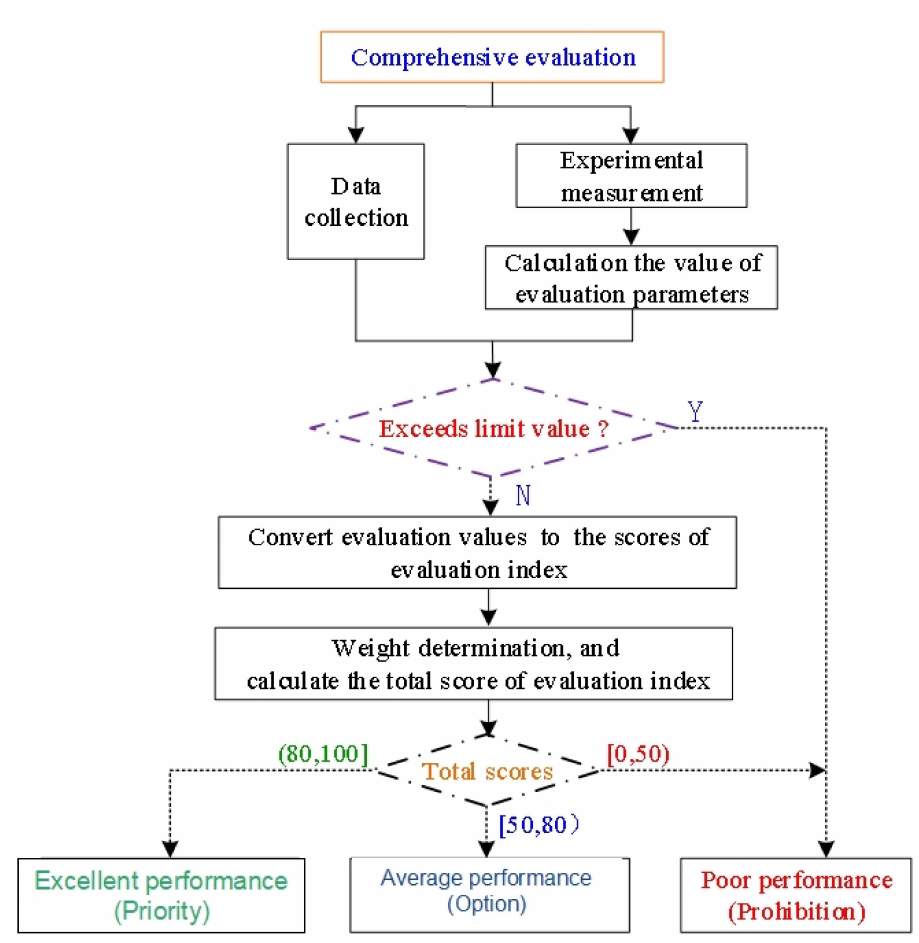
Figure 6. Flowchart of comprehensive evaluation of optimized dust